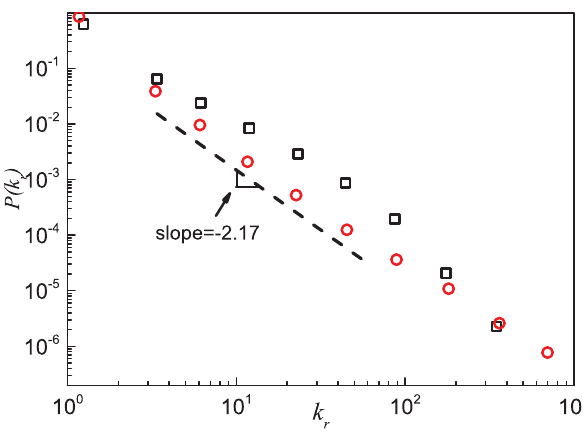
Figure 5. Mean reciprocal degree of nodes with (a) the same indegree and (b) the same outdegree in the Epinions social network and in the model. Results of the Epinions social network (black squares) and simulation results (red circles) based on the model are shown in a log-log scale in the main panels. Analytic treatment suggests that S k r T is linearly dependent on k in and k out , and the blue dash lines of slope 1 show its dependence. The inset in each panel shows the results in a linear scale and the dash line has a slope of 0 : 3 , as given by Eqs. (20) and (31). Data points are averages over the logarithmic bins of the indegree k in and outdegree k out , respectively.